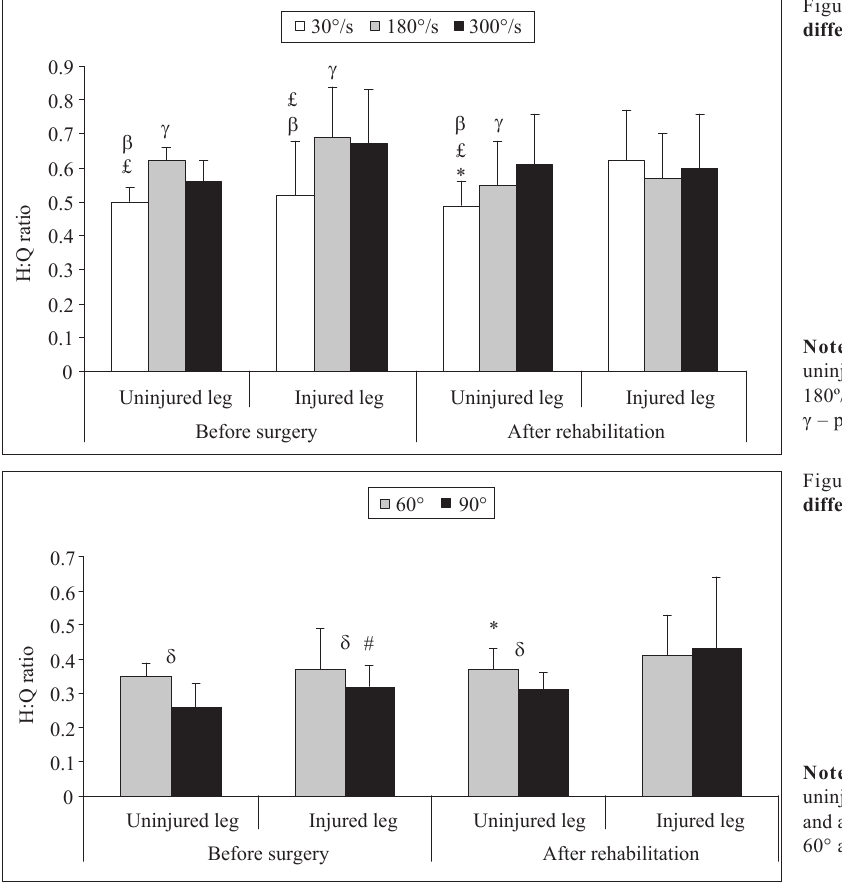
Note. * – p < 0.05 between injured and uninjured legs; # – p < 0.05 before surgery and after rehabilitation; δ – p < 0.05 between 60° and